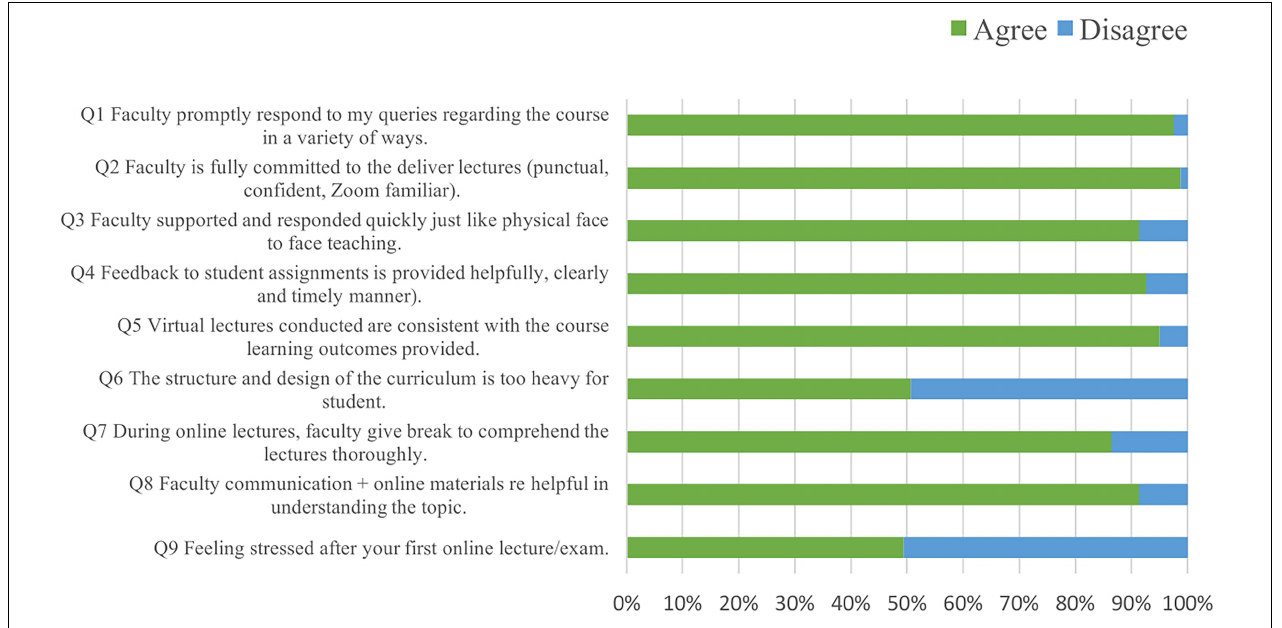
FIGURE 1 | Student’s satisfaction with Online T&L activities.